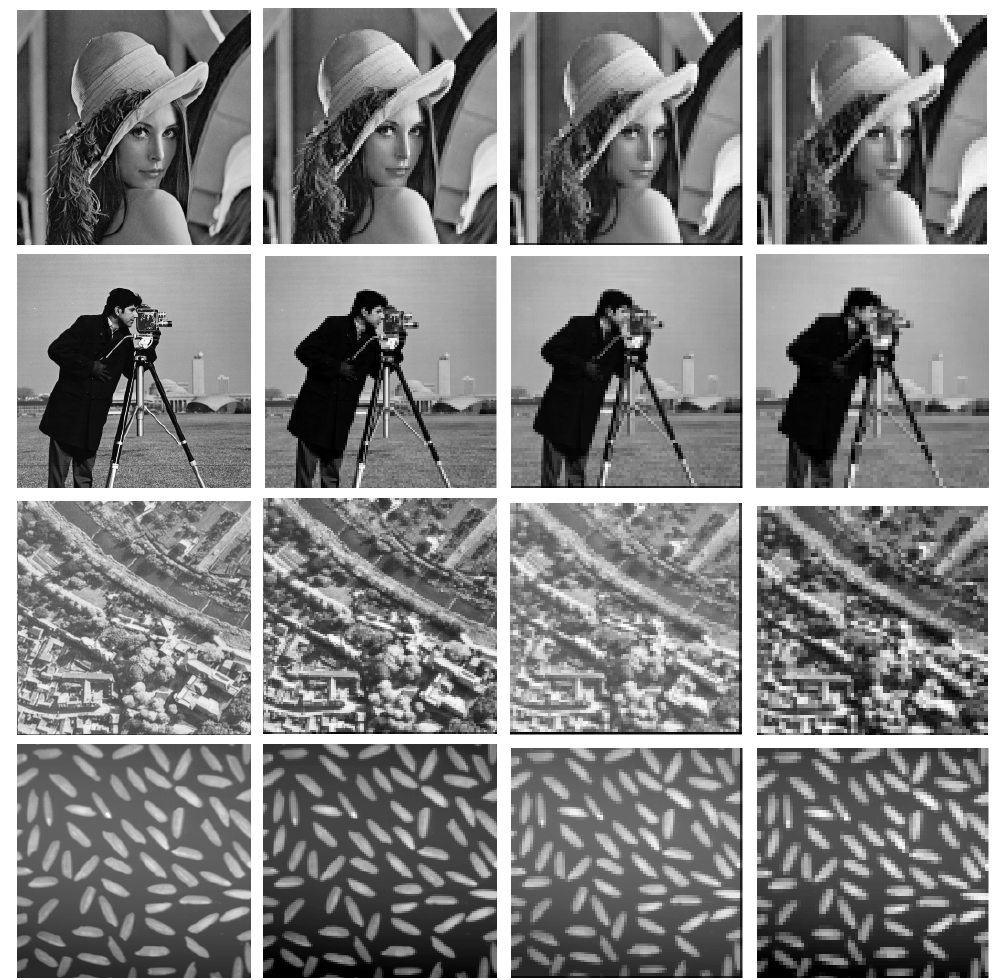
Figure 1: The first column: orinal images; the second column: reconstructed im- ages using 2 × 2 blocks at quality index 95 ; the third column: reconstructed images using 3 × 3 blocks at quality index 95 ; the fourth column: reconstructed images using 4 × 4 blocks at quality index 95